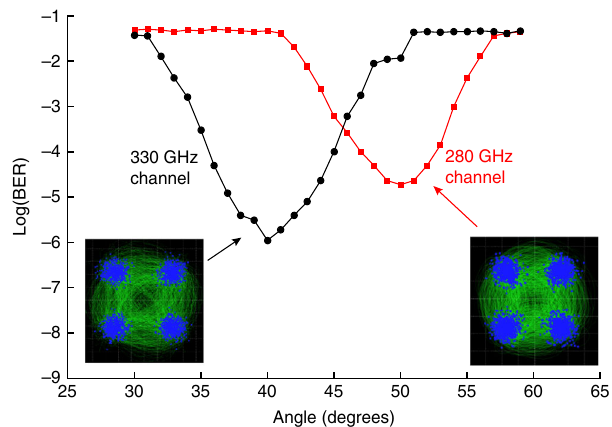
Fig. 4 Demux of two QPSK-modulated channels. BER vs. angle for two channels at 280 GHz and 330 GHz, both modulated at 12.5 Gbaud (corresponding to 25 Gb/s in each channel), for an aggregate throughput of 50 Gb/s. To preserve the QPSK phase information, signals were detected using a Schottky-based sub-harmonic mixer with the output analyzed on a real-time high-bandwidth oscilloscope. In both cases, the optimum BER is well below the threshold for forward error correction. The insets show the constellation diagrams measured for each channel. The vertical dashed lines show the predicted positions of the BER minima for the two channels, according to Eq.